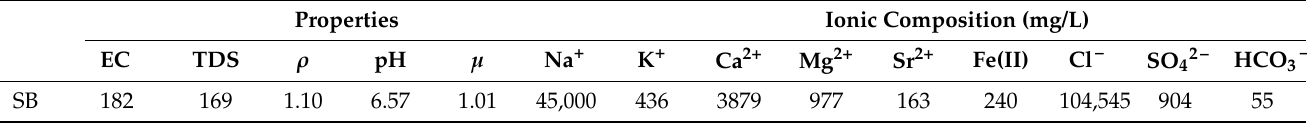
Table 4. Chemical analyses of Sønderborg geothermal brine (SB). Electrical conductivity (EC) in mS/cm, total dissolved solids (TDS) in ppt, density ( ρ ) in g/cm 3 , pH, viscosity ( µ ) in cP, and ionic composition in